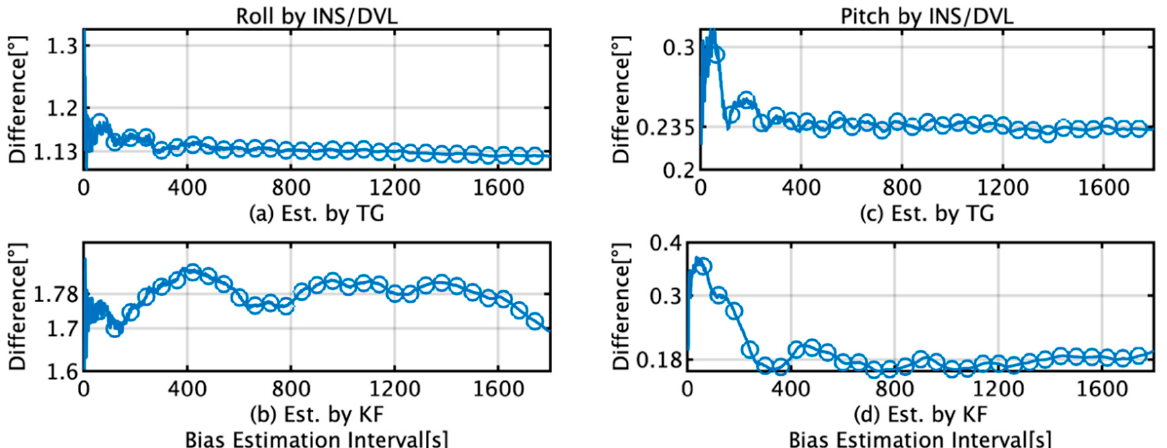
Figure 11. RMS difference between estimates by the INS/DVL and FOG during a 1 h voyage and the initial bias estimates from the TG and KF; ( a ) roll difference when initial bias is estimated by TG; ( b ) roll difference when initial bias is estimated by KF; ( c ) pitch difference when initial bias is estimated by TG; ( d ) pitch difference when initial bias is estimated by KF. Table 4. Maximum and minimum differences in the RMS roll and pitch when using the initial bias estimates from the TG and KF for INS/DVL.